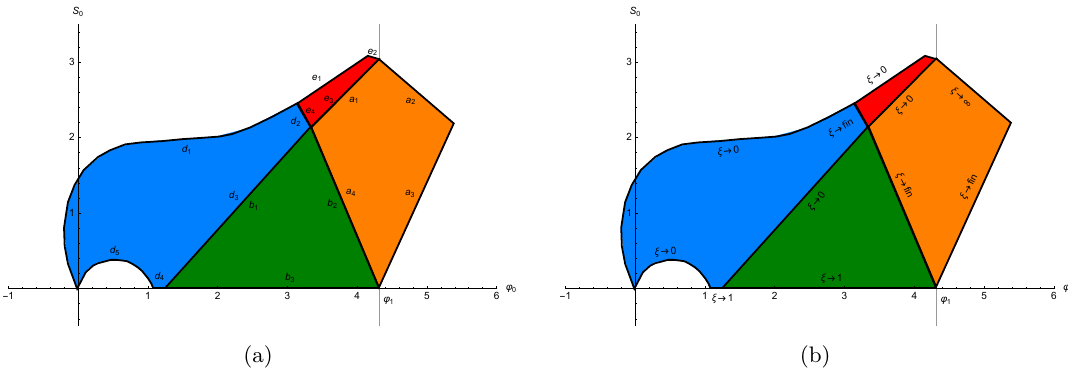
Figure 50 . (a) Space of solution with its boundaries. (b): the ratio of two relevant couplings, ξ , near the